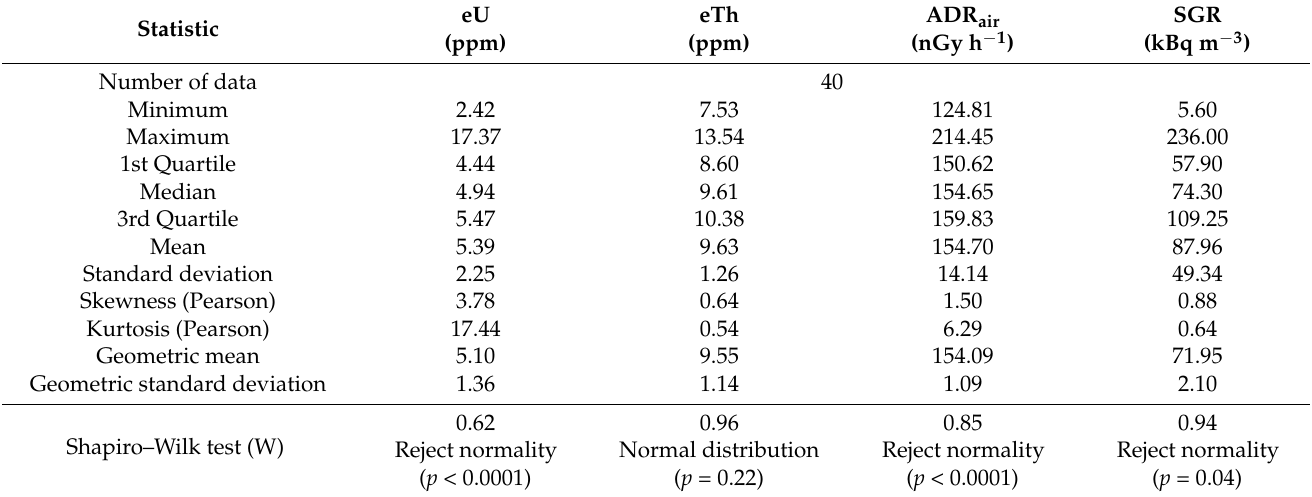
Table 1. Descriptive statistics of extracted airborne radiometric data and soil gas radon